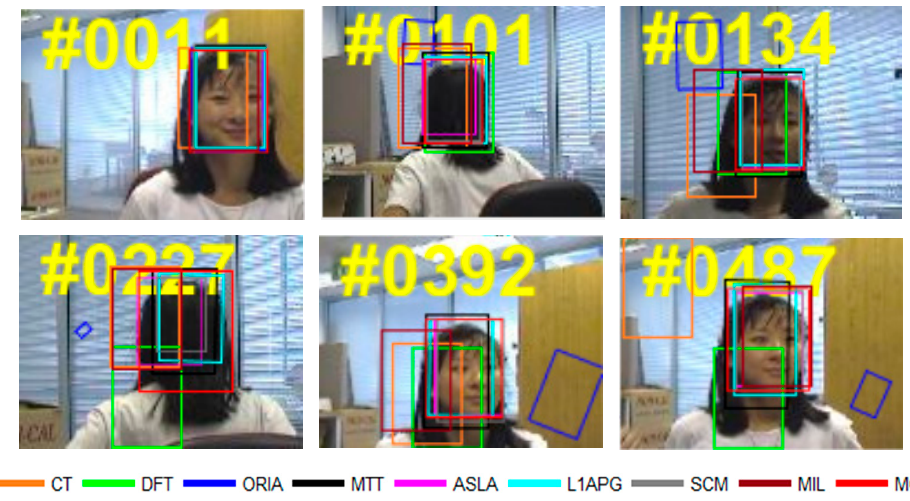
Figure 16. Tracking results on Girl .